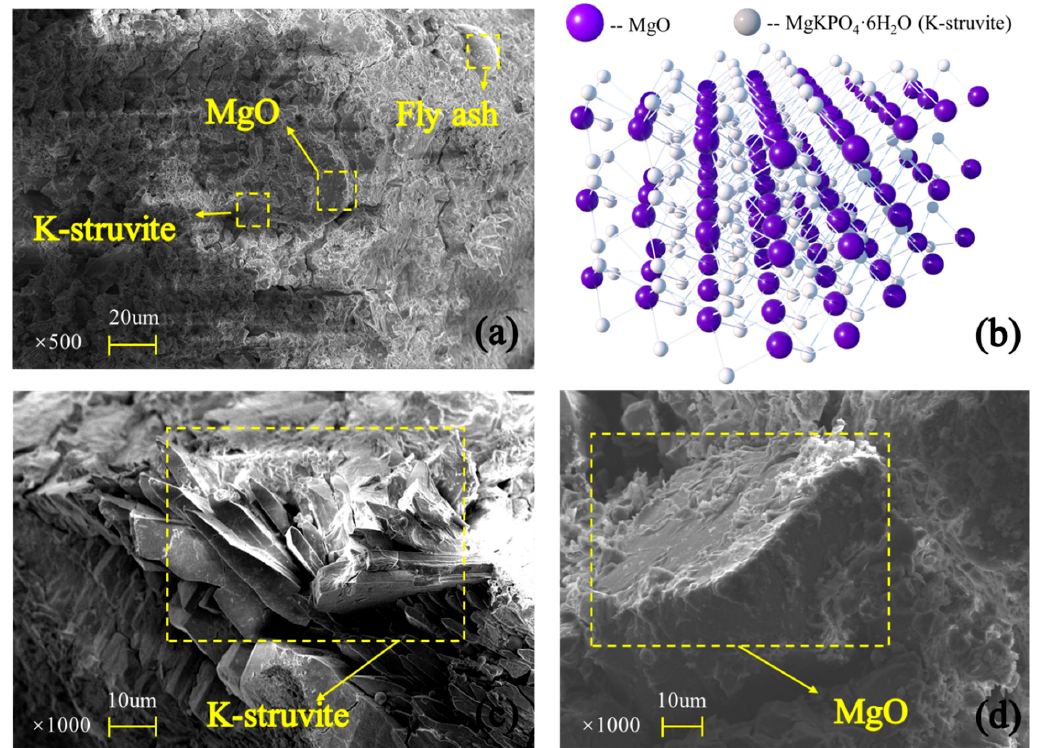
Figure 16. Scanning electron microscope (SEM) results: ( a ) MPC micromorphology; ( b ) schematic; ( c ) K-struvite; ( d ) MgO.